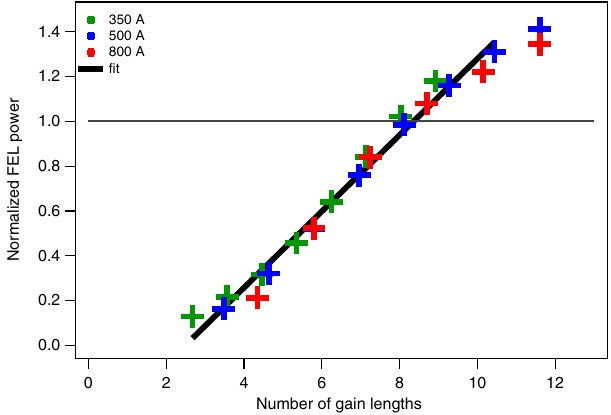
FIG. 4. Maximum power normalized to the saturation power for HGHG with three different values for the beam current, 350, 500, and 800 A (green, blue, and red, respectively). Normalized FEL power is reported as a function of the length of the radiator normalized to the FEL gain